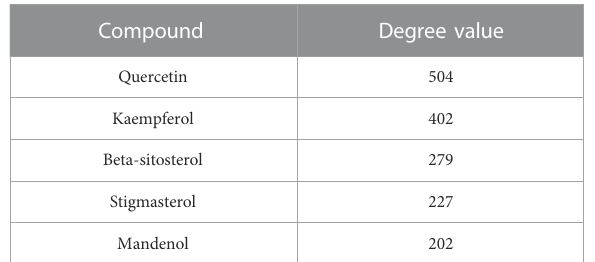
TABLE 2 Key active